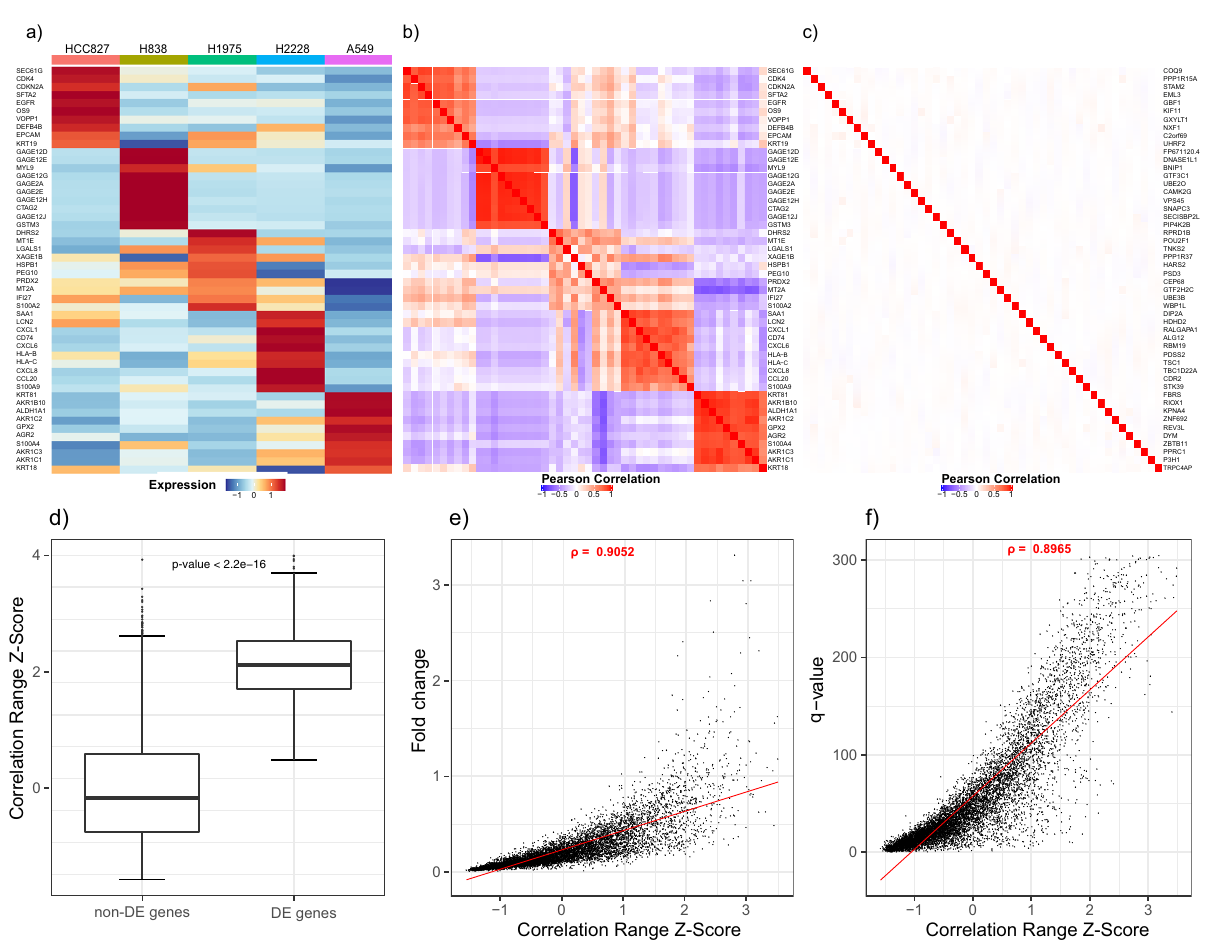
Fig. 2 Expression correlations of DE genes: scRNA-seq data from fi ve lung adenocarcinoma cell lines 28 . a Average expression of top 10 DE genes for each cell line. b Gene – gene correlations of the same genes. c Gene – gene correlations for non-DE genes. d Boxplot showing correlation range scores for non-DE and DE genes. DE gene computation is detailed in Supp. Note 1A. The middle line is the median, the lower and upper box limits correspond to the fi rst and third quartiles, the upper and lower whiskers extend upto 1.5*IQR from the top and bottom of the box, respectively (where IQR is the inter-quartile range), and data beyond the ends of the whiskers are outlying points that are plotted individually. P -value was calculated using two-sided Wilcoxon test ( n = 8602 expressed genes). e , f Scatter plot of genes showing correlation between e log2(fold change) of cell-type-speci fi c expression and f − log10( q - value) of cell-type-speci fi c expression with correlation range score. ρ : Spearman